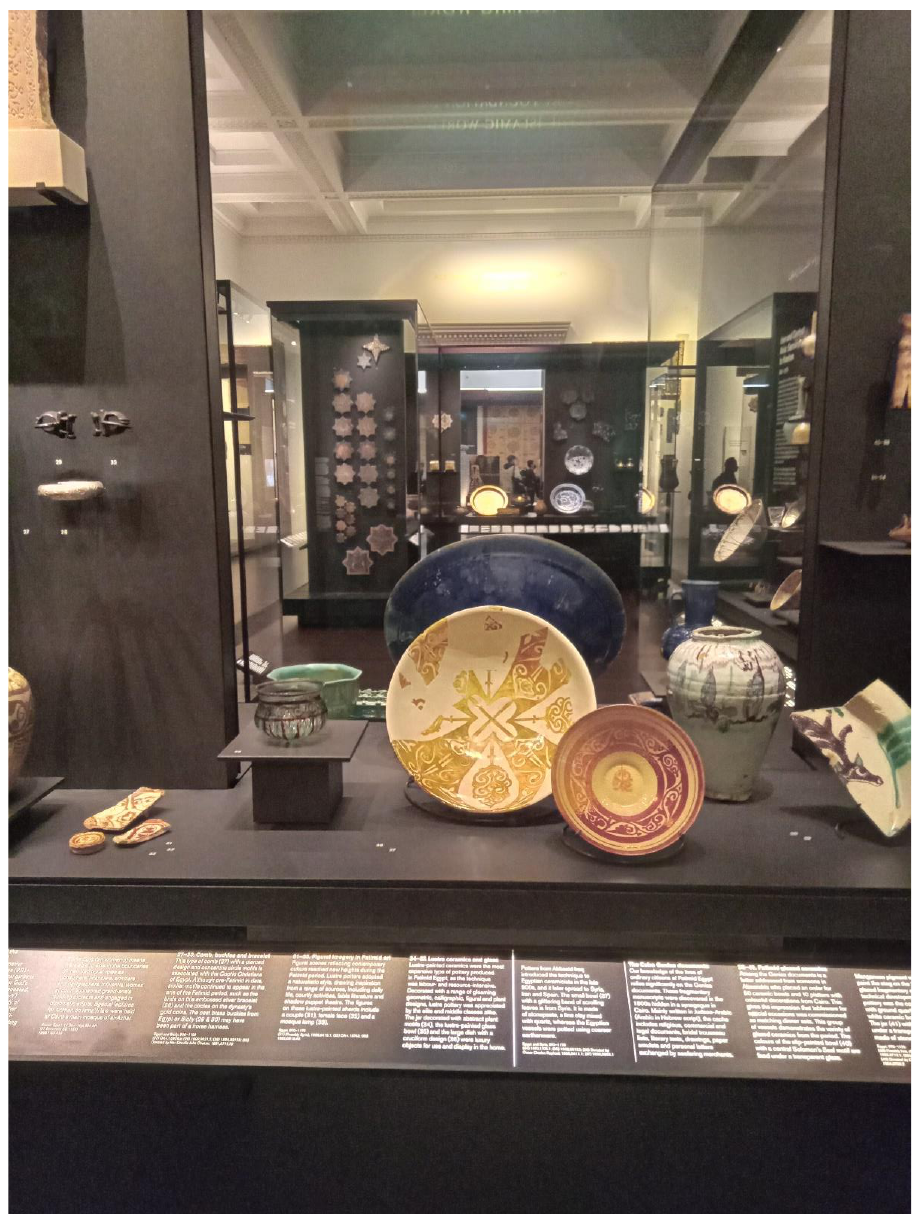
Figure 11. View of the displays in enfilade. The Albukhary Gallery, British Museum. Photos of the author.